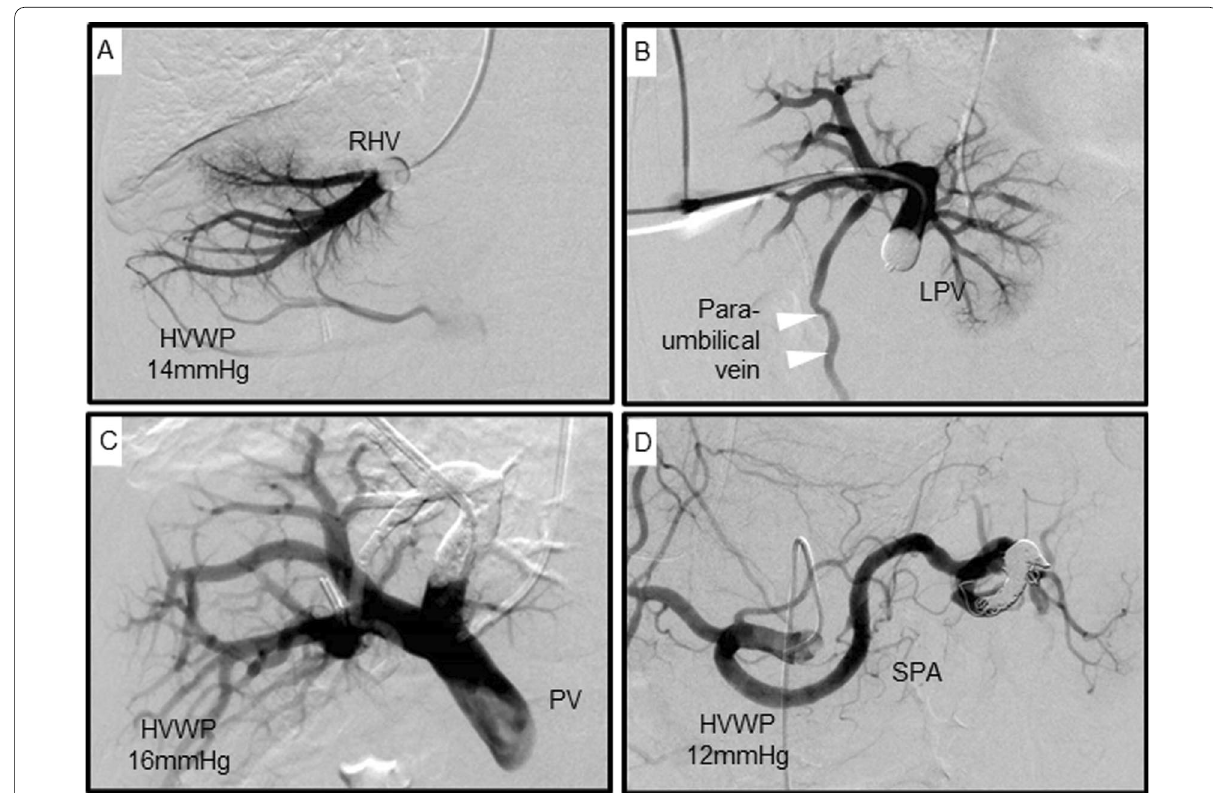
Fig. 2 PTPE and PSE were performed followed by measuring the right hepatic vein wedged pressure (HVWP) ( A ). Left portal vein angiography shows the paraumbilical vein ( B , arrowhead), and we performed embolization at root of blanch ( C ). Splenic artery was embolized at splenic hilum ( D